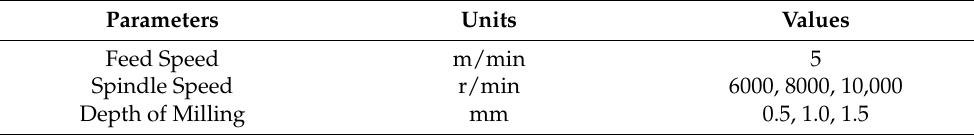
Table 3. Milling